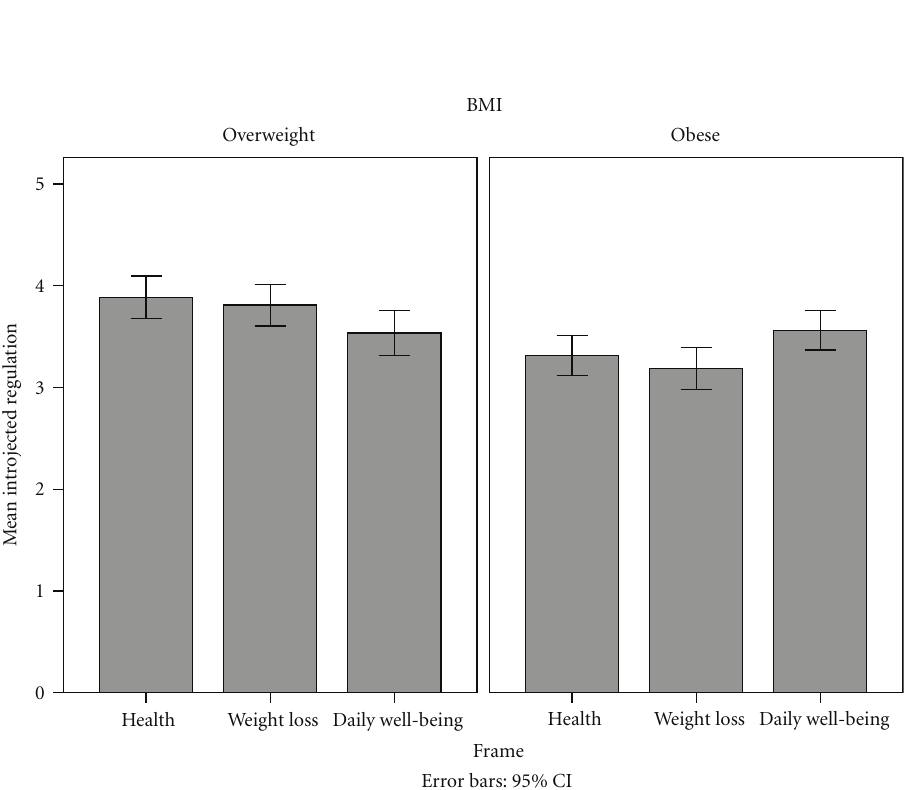
Figure 1: Controlled regulation.